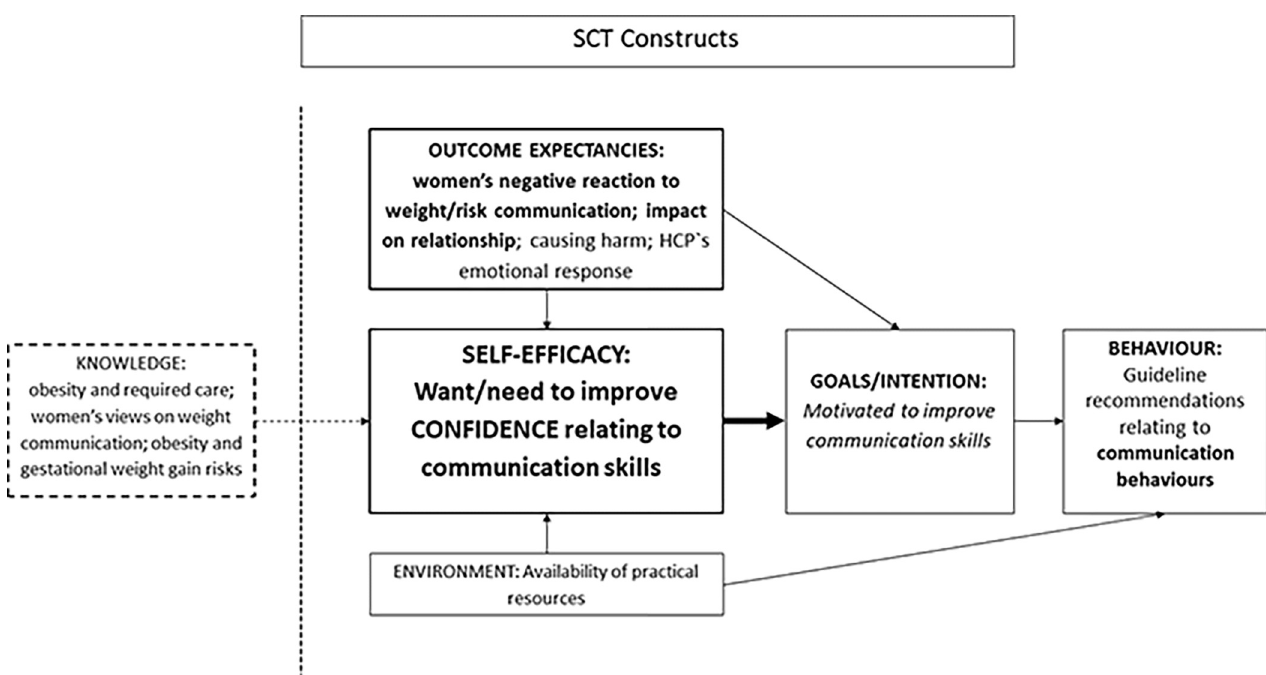
Fig 2. SCT theoretical model for implementation of guideline recommendations for weight management in pregnancy: Communication-related behaviours. SCT = social cognitive theory. Self-efficacy, outcome expectancies, goals/intentions and environment are SCT constructs relating to behaviours. Knowledge was identified as an important additional construct in the evidence base having an influence on self-efficacy. Bold and larger font size represent the key barriers to practice. Italics font represents facilitators to practice.